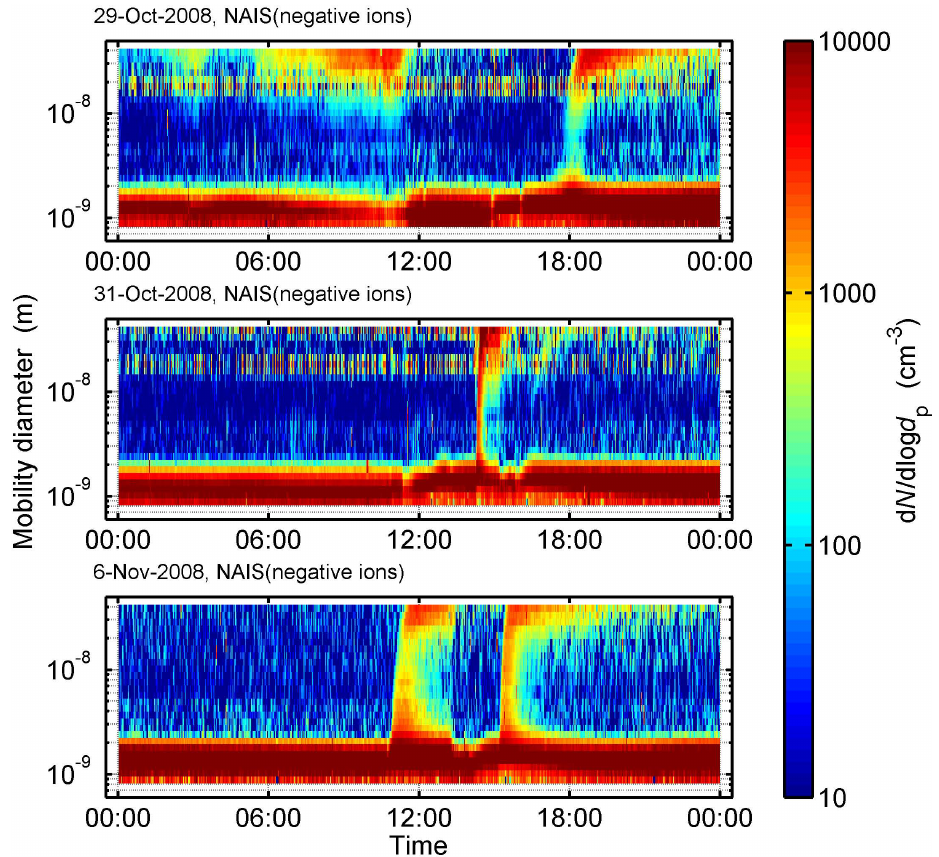
Fig. 5. Self-ending banana/stick events. Top: limonene event on 29 October 2008, produced in an empty chamber with initial ozone concen- tration of 10ppb. Middle: Limonene event on 31 October 2008, with initial ozone concentration of 16ppb. Bottom: 1 3-carene and α -pinene events on 6 November 2008, produced at 14 and 20ppb of ozone,